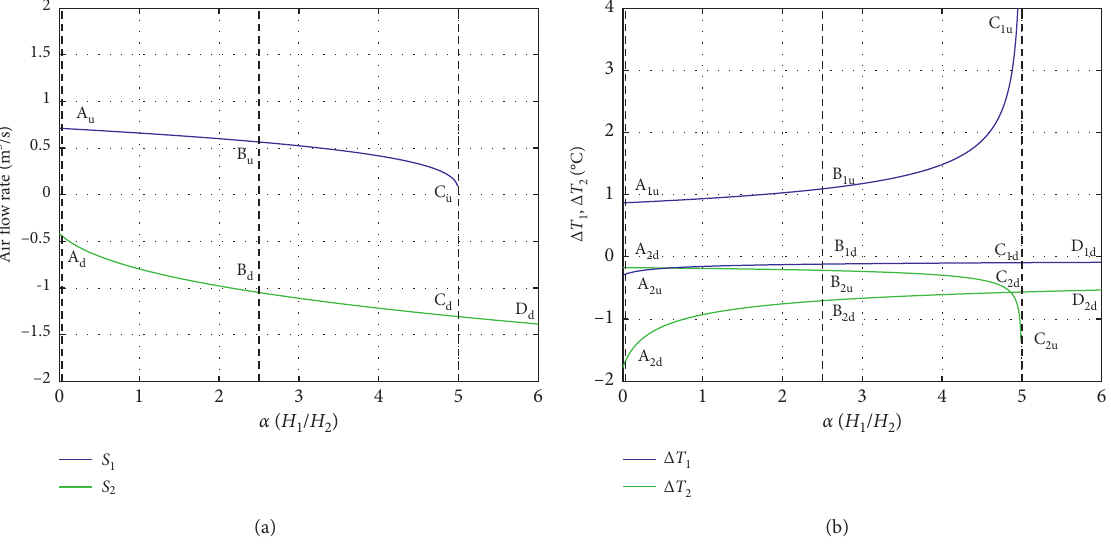
Figure 7: Bifurcation diagram. (a) Air flow rate. (b)